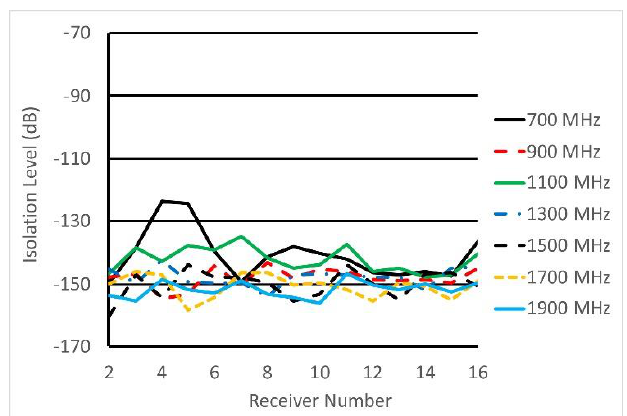
Figure 10. Isolation levels measured at receivers for signal transmission from Channel 1 at 7 frequencies when remaining channels were activated in the receive mode and antenna ports were terminated with a 50 Ω matched load. Except for the 700 MHz case, all values are less than or equal to −135 dB.